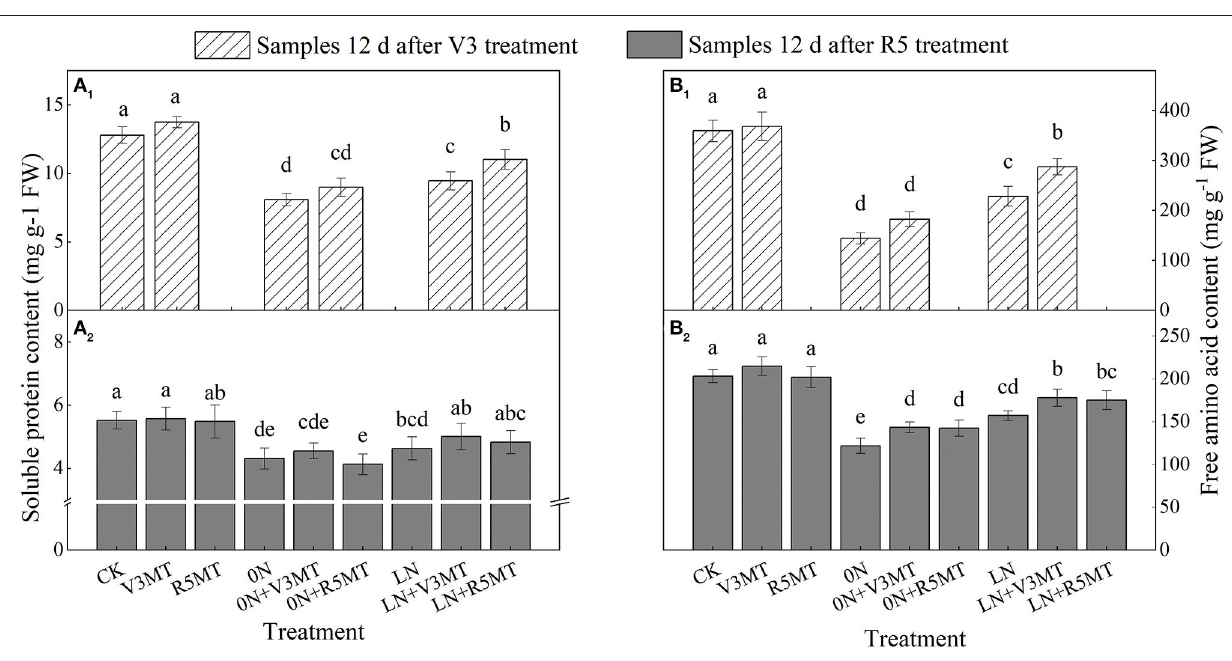
FIGURE 5 | The effect of exogenous melatonin (V3 and R5) on the content of soluble protein (A) and free amino acid (B) in plant leaves under three N levels. The abbreviated meaning of each treatment is the same as in Figure 3 . The values were presented as mean ± SE ( n = 3). Different letters in one measuring group indicate statistically significant differences when P ≤